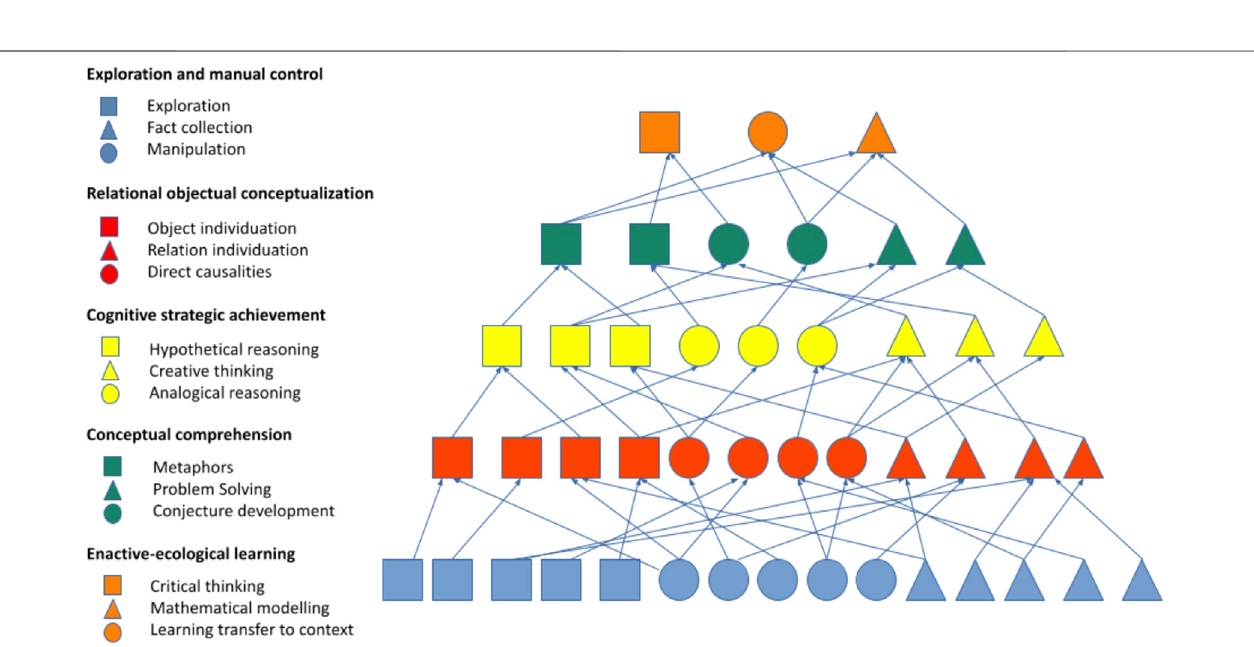
Frontiers in Education |